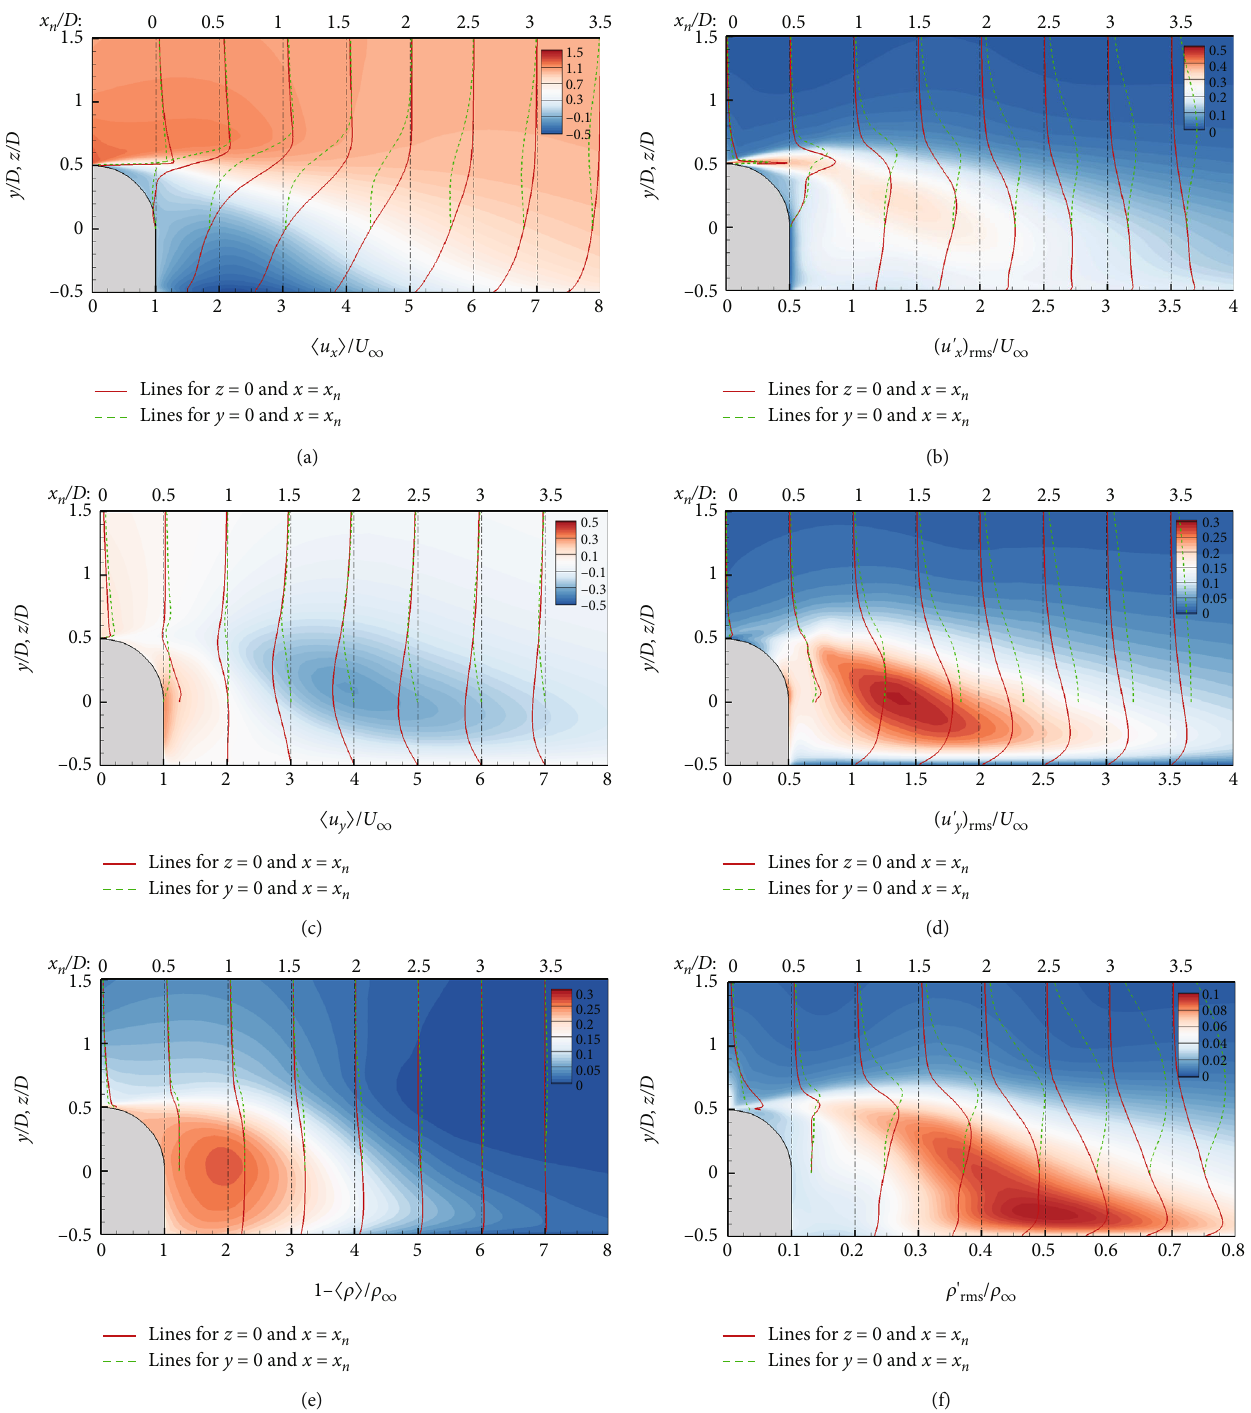
Figure 11: Time-averaged and fl uctuation pro fi les of streamwise velocity, spanwise velocity, and density behind the turret, and it is colored by correlation quantities along the turret centerline ( z = 0 ): (a, b) streamwise velocity, (c, d) spanwise velocity, and (e, f) density, where the solid red lines represent pro fi les along the turret centerline ( z = 0 ), and the dashed green lines represent pro fi les on the horizontal plane ( y = 0